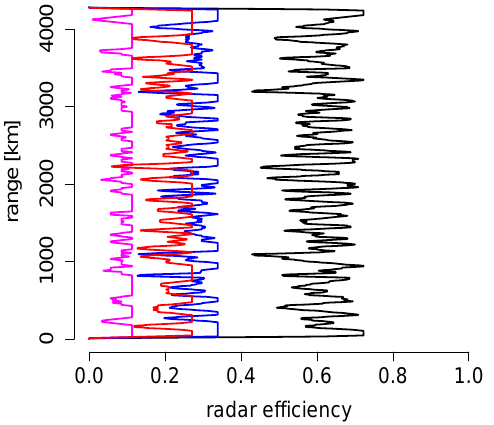
Fig. 3. Radar efficiency for standard EISCAT UHF experiment “manda”. Here efficiency value 1.0 would mean that the maximum duty cycle of 12.4% is fully used. Though the experiment is anal- ysed up to larger ranges than the length of one IPP, a “dead” range is produced around 300km from which no echoes are received.